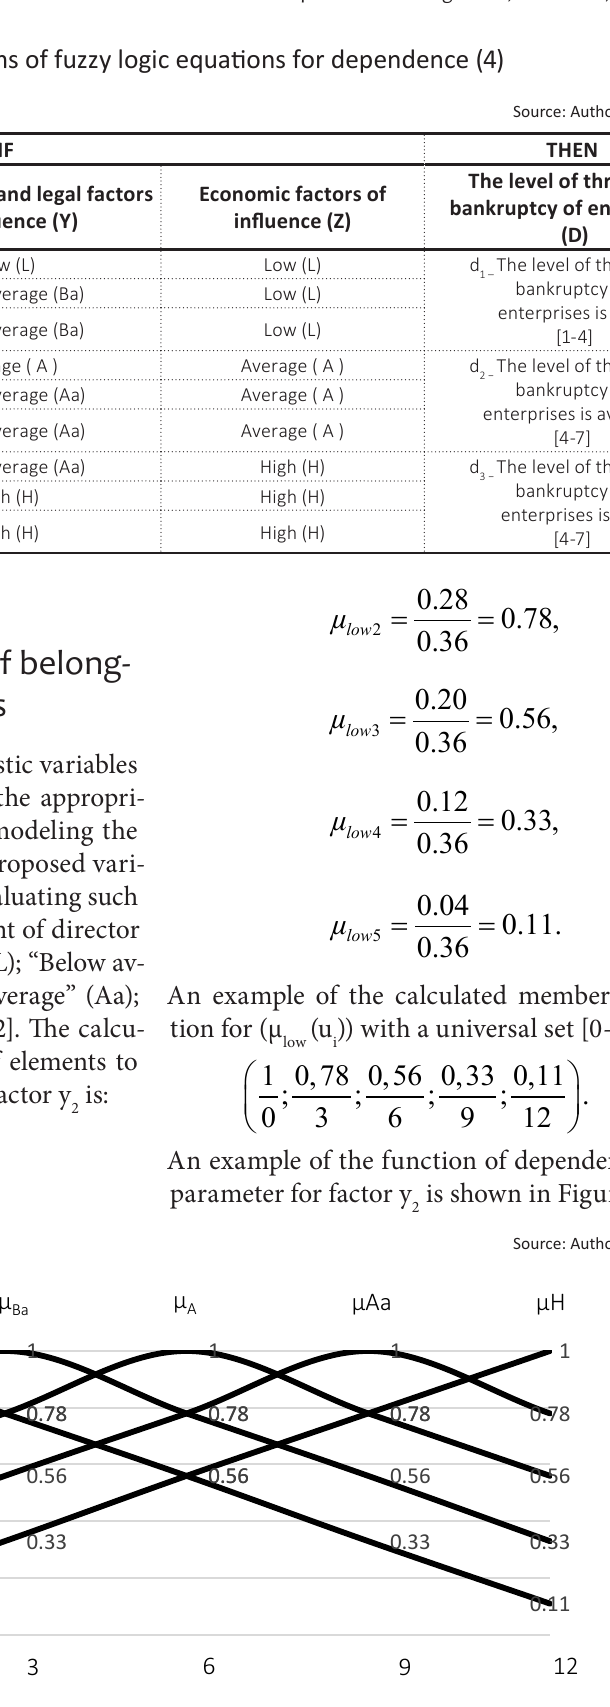
– index of legal responsibility of 2